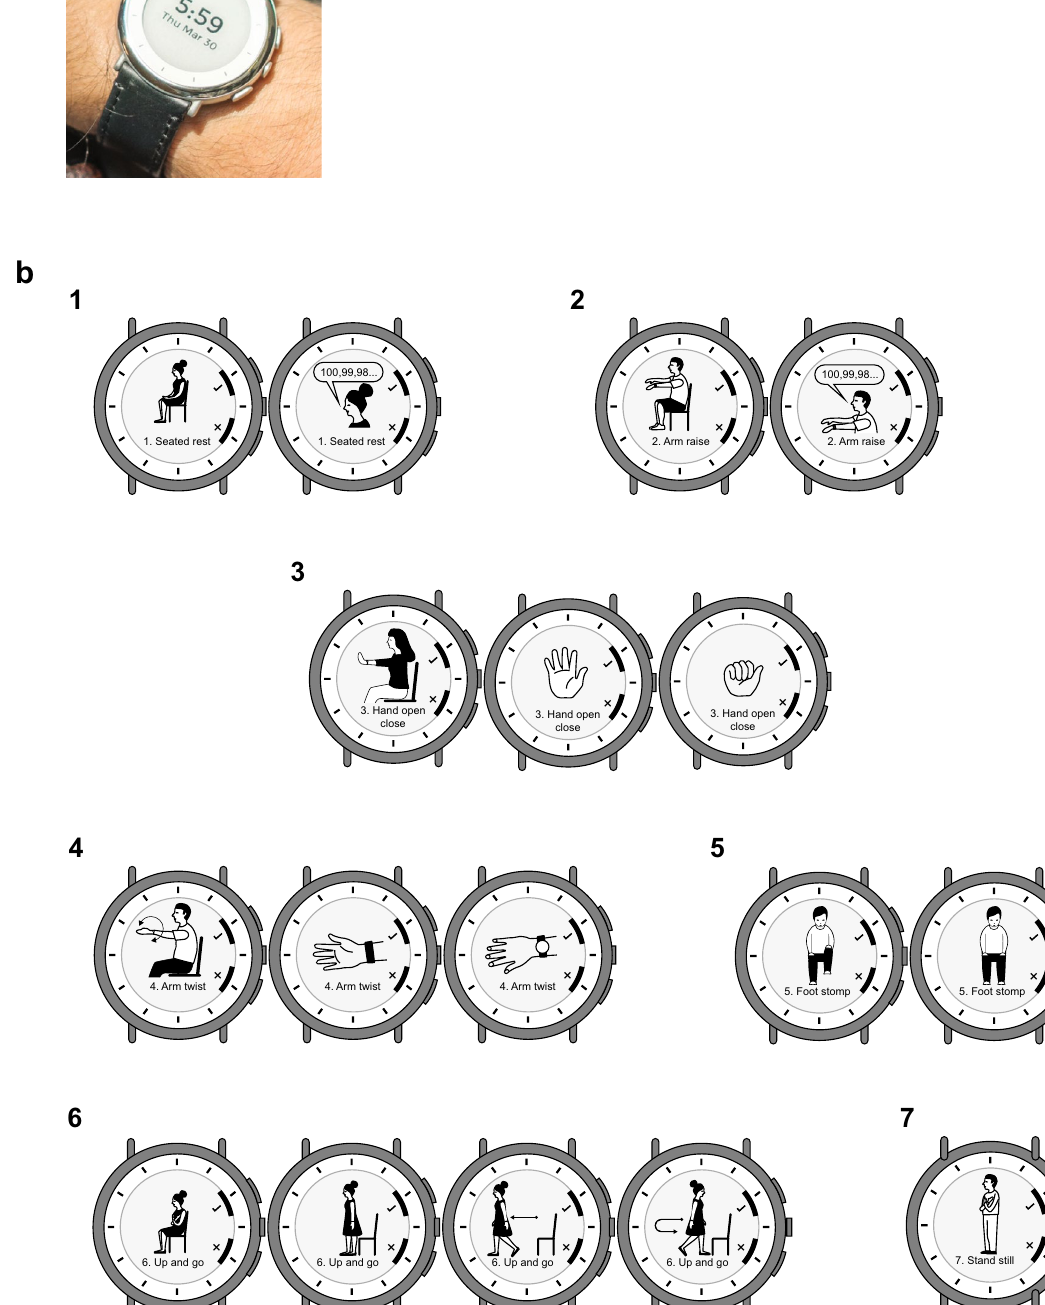
Figure 1. Study Watch and watch face showing the virtual motor examination. ( a ) Study Watch worn on the wrist and ( b ) Study Watch face showing the virtual motor examination. The virtual motor examination comprised seven structured motor tasks, which were programmed into the smartwatch and completed by patients in order from task 1 through task 7. Tasks 1 (seated rest/rest tremor), 2 (arm raise/postural tremor), 3 (hand opening/closing), 4 (arm twist/pronation/supination), and 5 (foot stomping) were completed seated. Tasks 6 (up and go) and 7 (stand still/postural stability) required the patient to